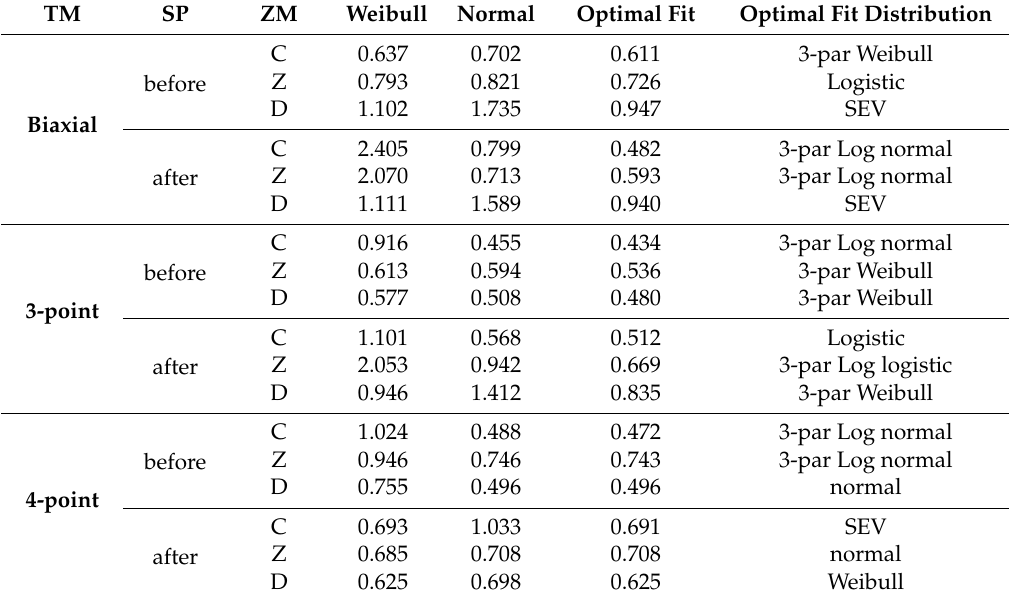
Table 4. Anderson-Darling goodness of fit